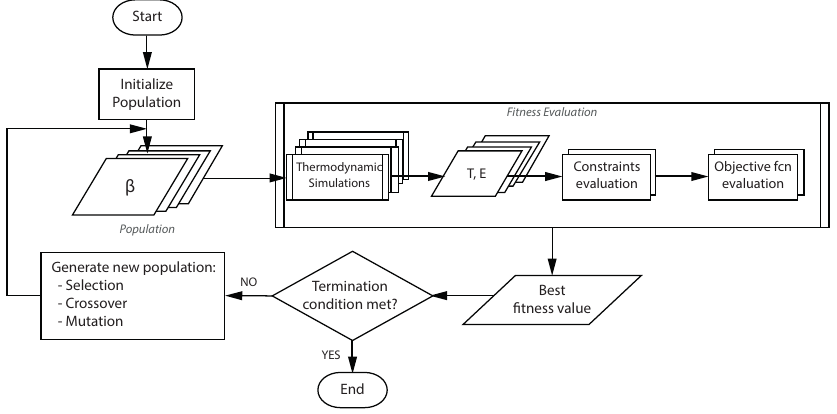
Figure 3. Flowchart of the genetic algorithm-based